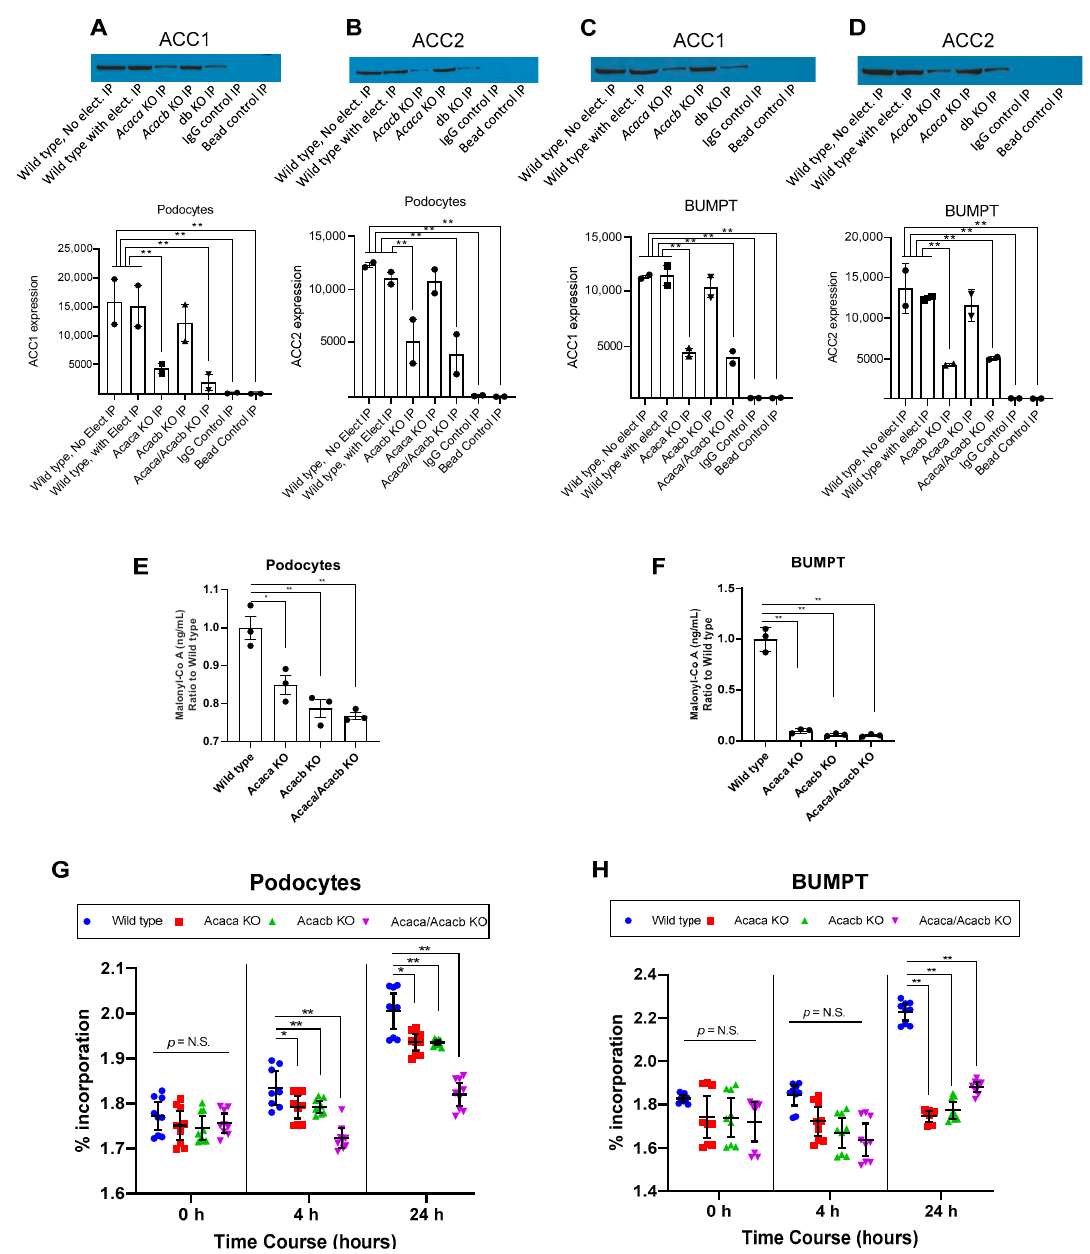
Figure 2. Acaca and Acacb knocking out using CRISPR-Cas9 halts glycemic mediated upregulation of DNL in podocytes and BUMPT cells in vitro. Measurement of protein expression by immunopre- cipitation showed that Acaca KO and Acaca/Acacb double KO decreased expression of ACC1 protein in podocytes ( A ). Acacb KO and Acaca/Acacb double KO decreased expression of ACC2 protein in podocytes ( B ). Acaca KO and Acaca/Acacb double KO decreased expression of ACC1 protein in BUMPT cells ( C ). Acacb KO and Acaca/Acacb double KO decreased expression of ACC2 protein in BUMPT cells ( D ). For immunoprecipitation blots, wild ‐ type cells with and without electroporation were used as positive controls, and IgG and control beads were used as negative loading controls ( A – D ). Acaca and Acacb gene KO in podocytes ( E ) and BUMPT cells ( F ) cultured in high glucose concentration (25 mM) suppressed production of malonyl ‐ Co A compared to wild ‐ type cells. KO mitigated the time dependent increase in percentage of labeled palmitate exposed to high glucose concentration (25 mM) compared with wild ‐ type podocytes ( G ) and BUMPT cells ( H ) * p < 0.05, ** p ≤ 0.01. Values are mean and standard errors. Number of experiments is 2 in panels A to d, 3 in panels E and F, and 3 with each experiment in triplicates in panels G and H.